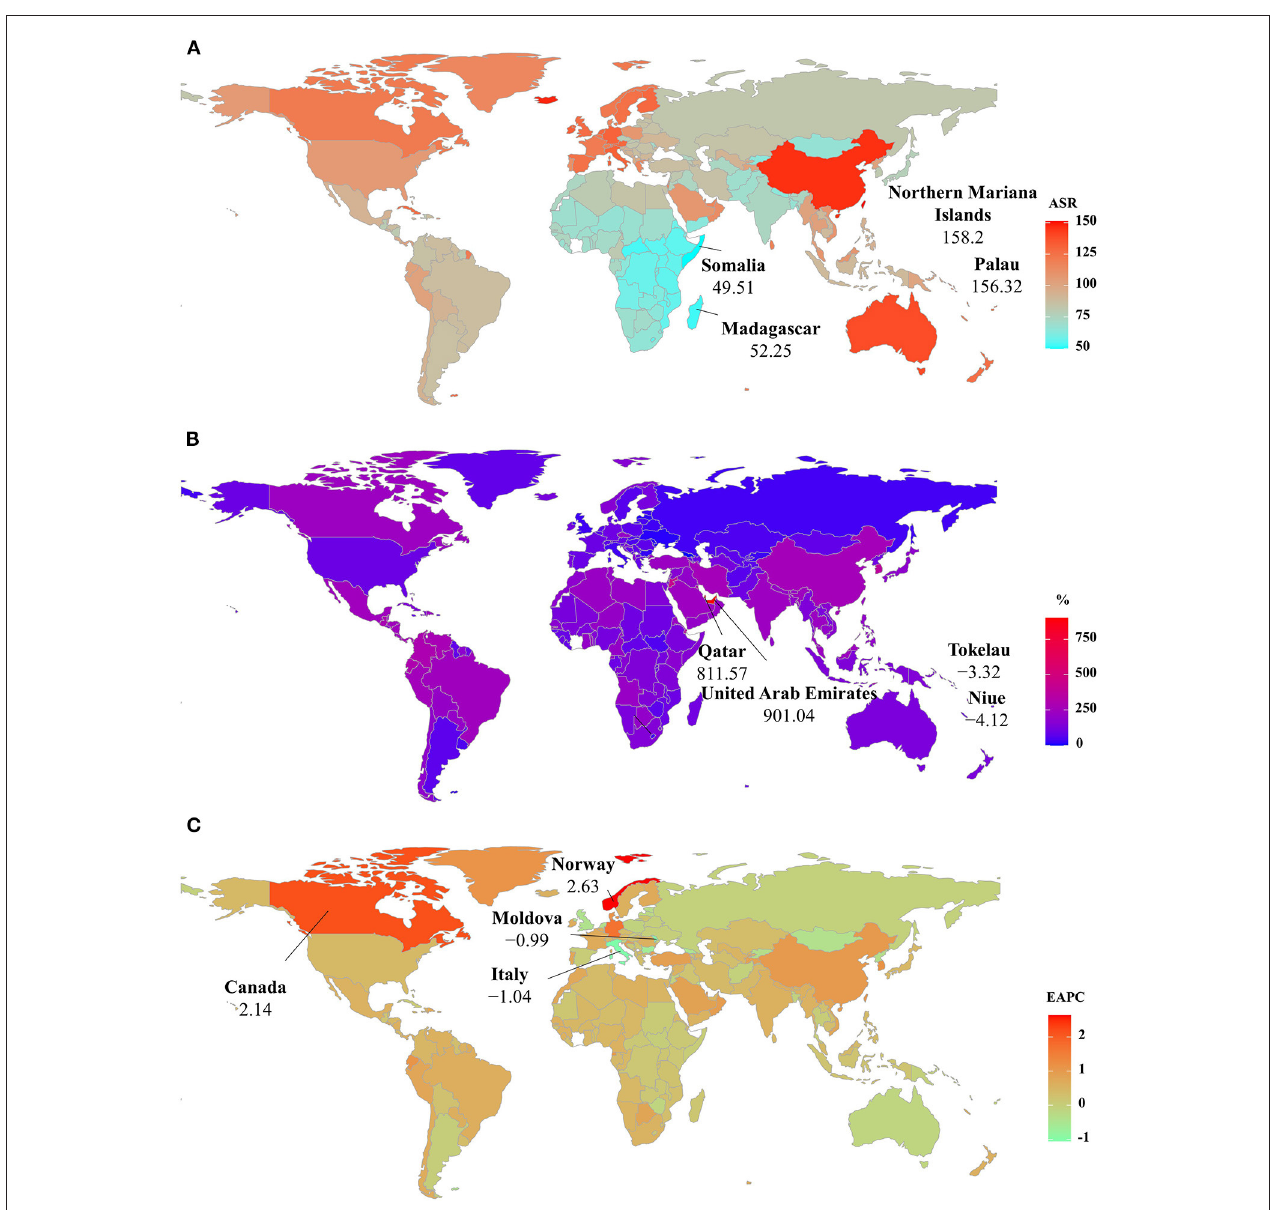
FIGURE 5 | The distribution of ASRs, percentage changes, and EAPCs of Parkinson’s disease prevalence at the national level. (A) was the ASR in 2019; (B) was the percentage changes in number between 2000 and 2019; (C) was the EAPCs in countries/territories, respectively. Countries/territories with an extreme value were annotated. ASR, age-standardized rate; EAPC, estimated annual percentage change.